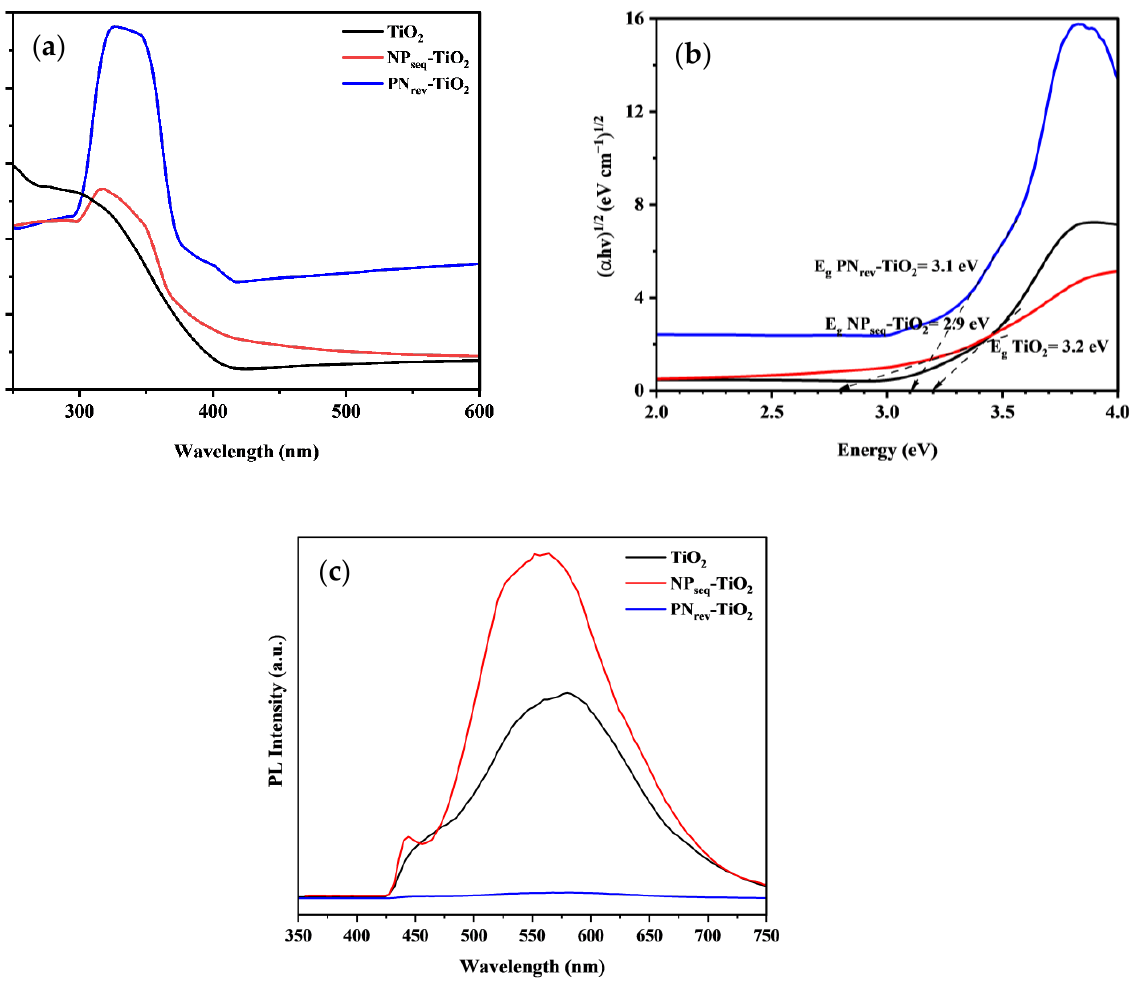
Figure 8. The UV-Vis/DRS analysis for TiO 2 , NP seq -TiO 2 , and PN rev -TiO 2 photocatalysts: ( a ) absorbance spectra, ( b ) Tauc’s plot, and ( c ) PL spectra for TiO 2 , NP seq -TiO 2 , and PN rev -TiO 2 photocatalysts.